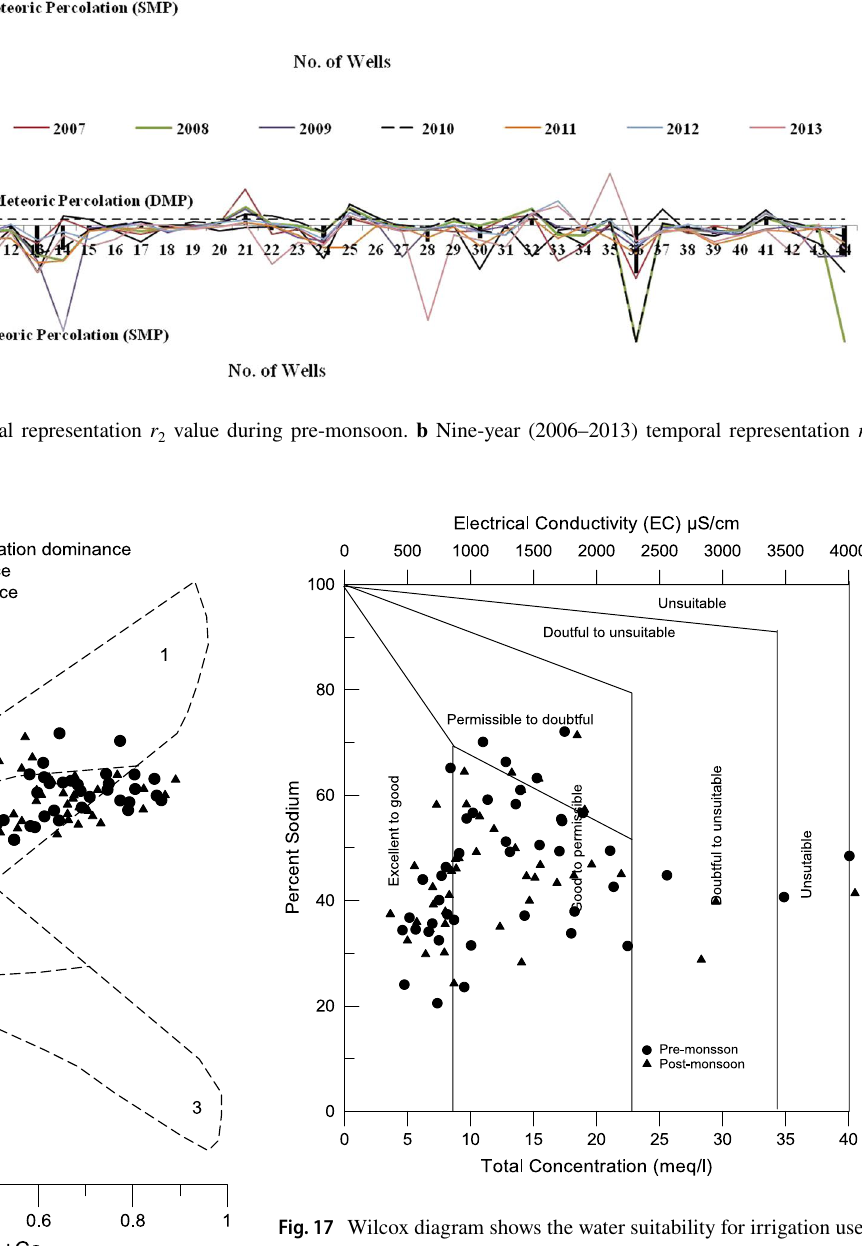
Fig. 17 Wilcox diagram shows the water suitability for irrigation than 1 (− 1.12 and − 1.46, pre- and post-monsoon, respec- tively). In yearwise average, water type was also found as Na + –SO 42− (in both sessions); however, few r reported greater than 1 (because maximum value of r